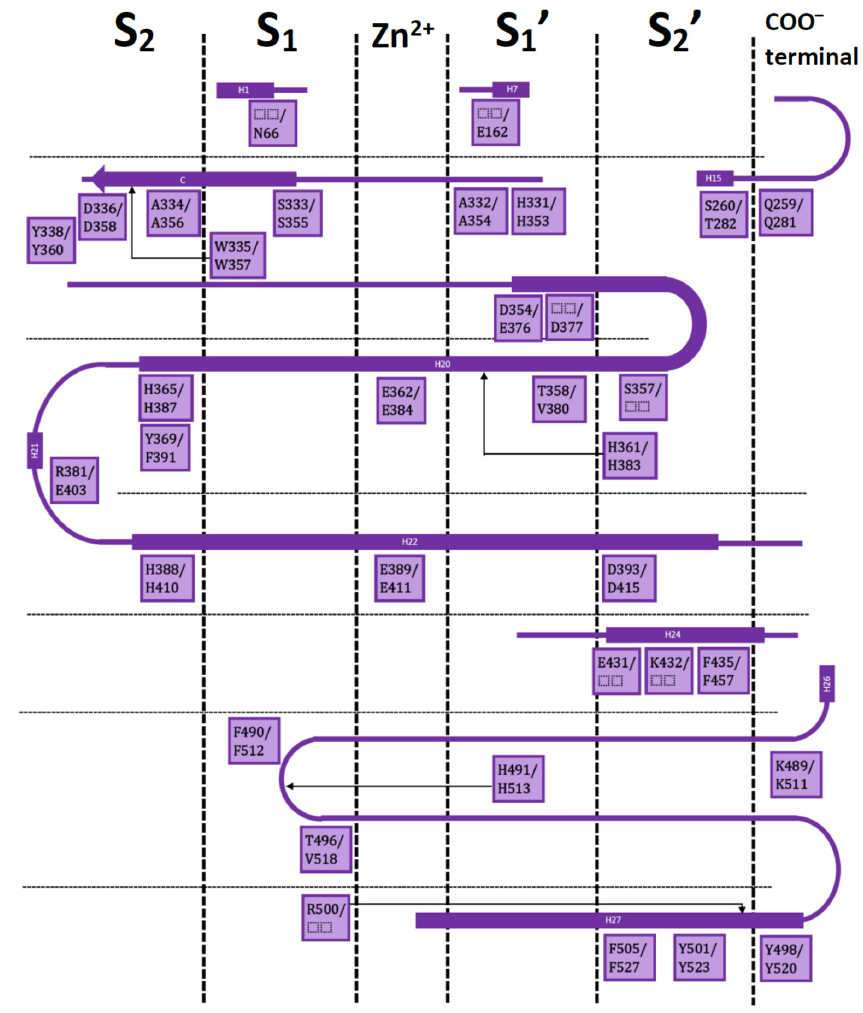
Figure 1. Residues in the S 2 , S 1 , S 1 ′ , and S 2 ′ subsites with respect to the catalytic Zn 2+ for nACE/cACE and their position in the sequences. Squares have nACE residues before the slash and cACE residues after the slash. Only residues from the IFP analysis are included.